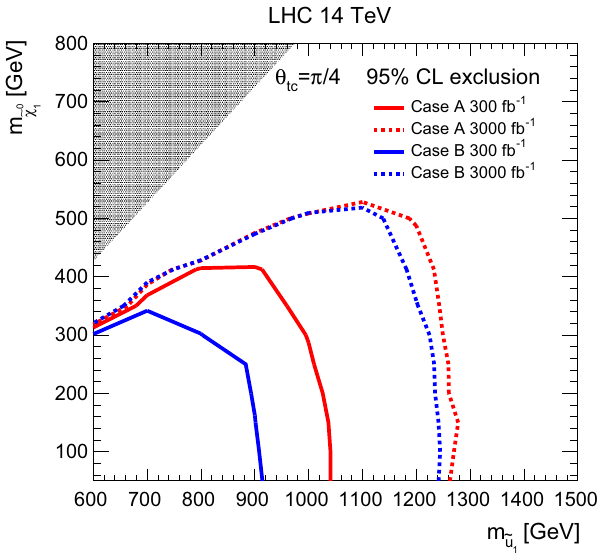
Fig. 4 Left: sensitivity of the LHC to our mixed stop-scharm scenarios given as 95% CL exclusion contours in the ( m ˜ u Case-A (red) and Case-B (blue) analysis strategies and for 300 fb − 1 (solid) 3000 fb − 1 (dashed). The projected excluded region lies between